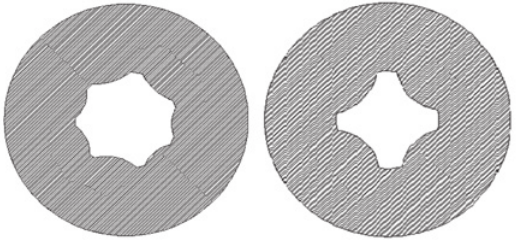
Fig. 7. 7-pointed rose petal grain, 4-pointed star grain (geometry with port area